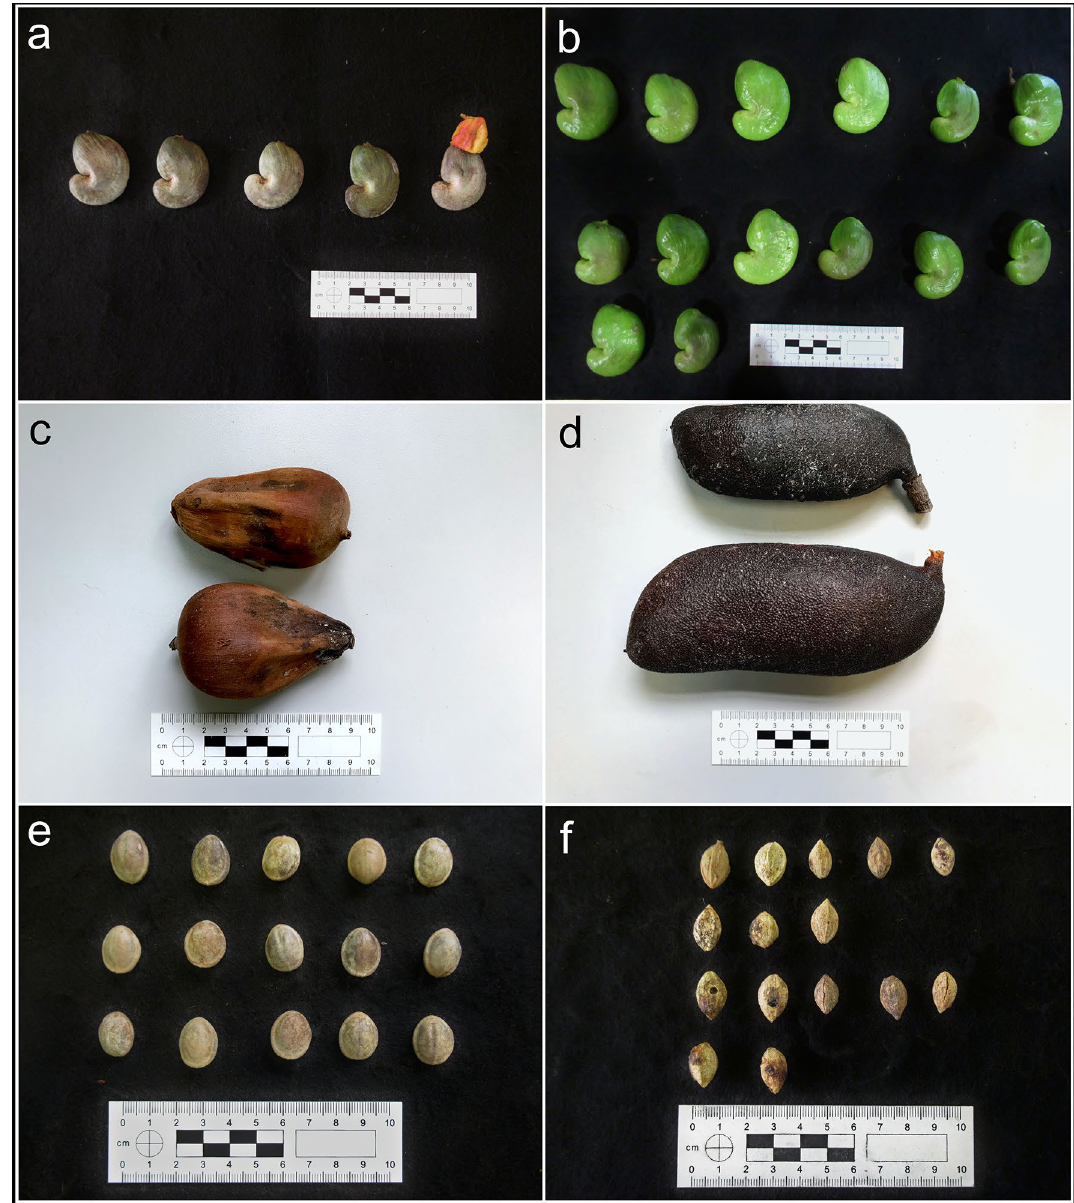
Figure 2. Food resources sampled. ( a ) Dry cashew nut, Anacardium ; ( b ) fresh cashew nut, Anacardium ; ( c ) palm nut, Attalea ; ( d ) jatobá pod, Hymenaea ; ( e ) Manihot seed; ( f ) Mirindiba, Buchenavia grandis